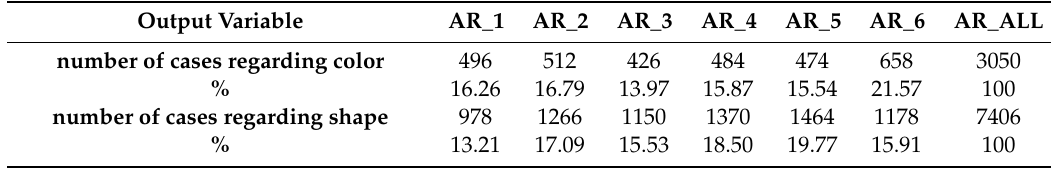
Table 2. Layout of frequency of output variables in training set.